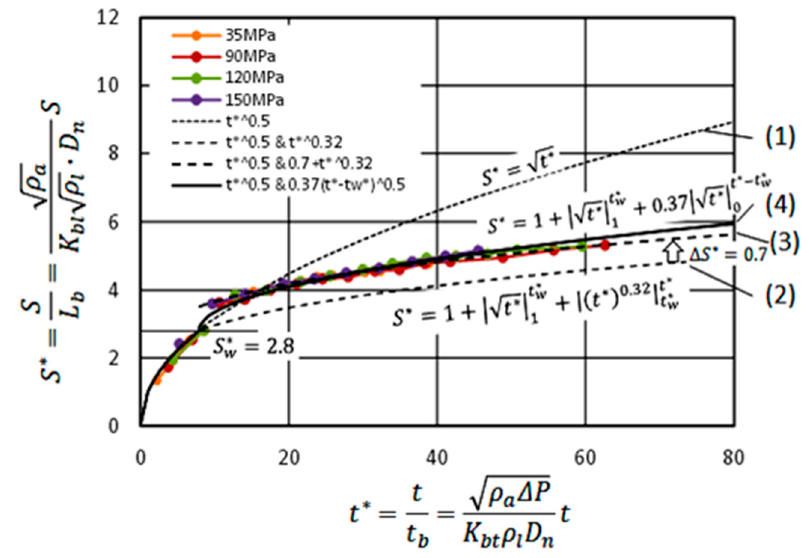
Figure 15. Normalized spray penetration after wall impingement.